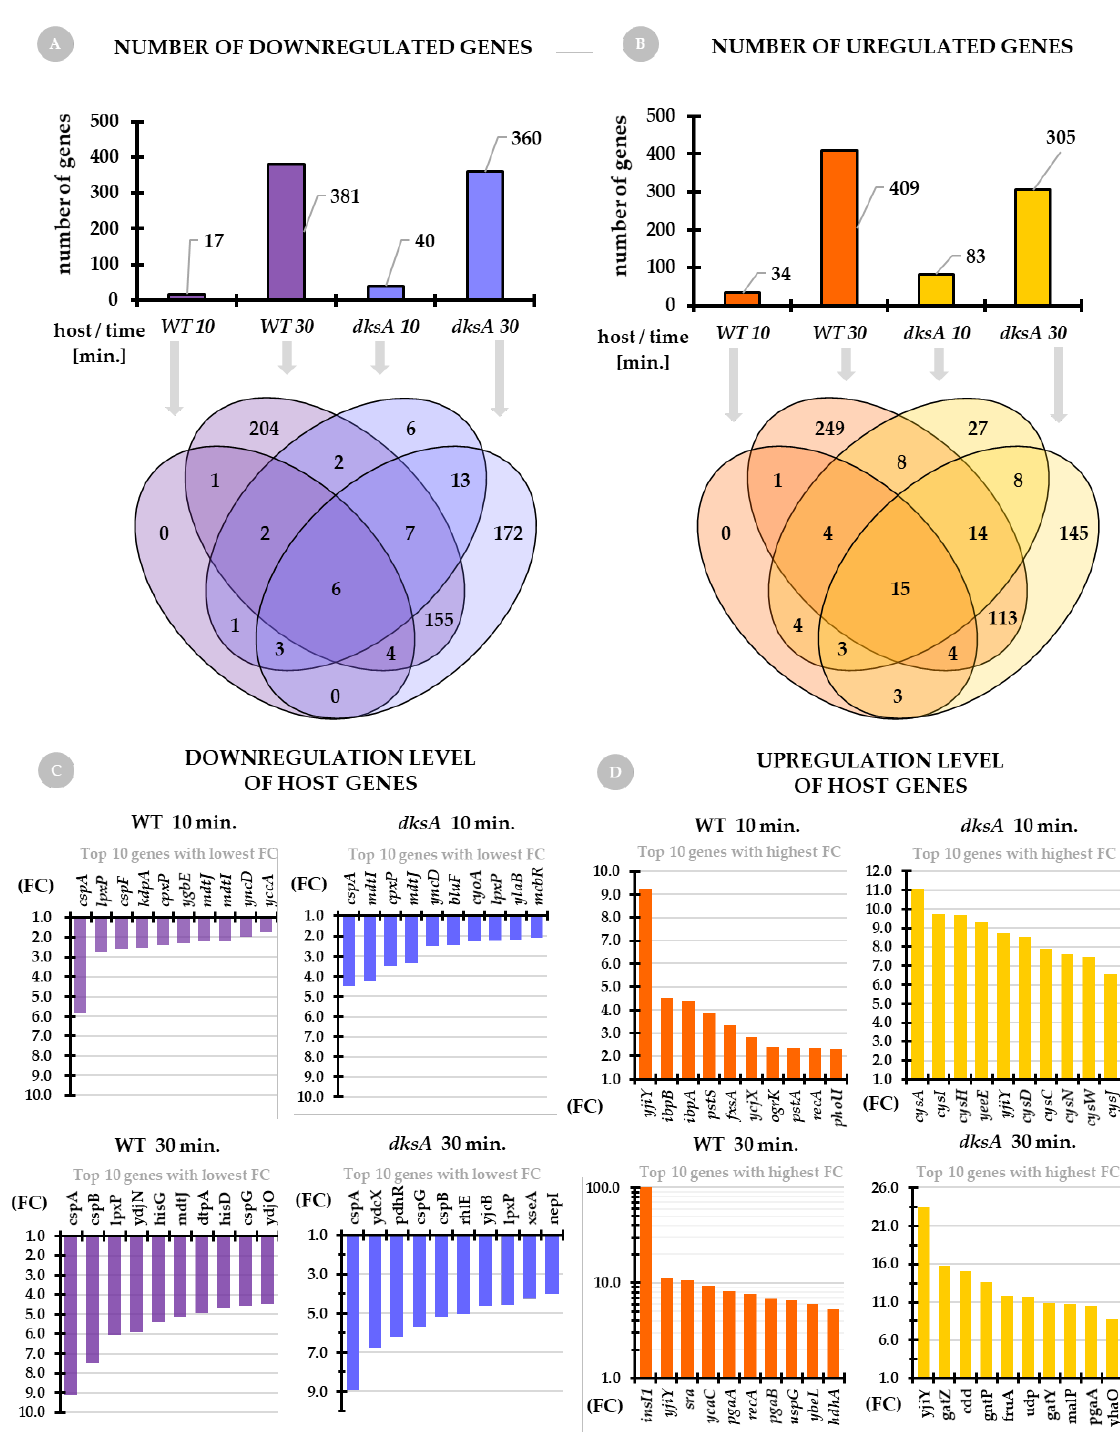
Figure 3. General overview of the host transcriptome upon P1 vir infection. Panel ( A ) shows the number of downregulated genes of both, the wild type and dksA mutant hosts at 10 min and 30 min post-P1 vir infection. Panel ( B ) shows the number of upregulated genes of both hosts at selected time points upon P1 vir infection. Venn diagrams below panels A and B show the distribution of up- or downregulated genes. Panel ( C ) shows the downregulation level of the top ten genes with the lowest expression at each time-point and host. Panel ( D ) shows the upregulation level of the top ten genes with the highest expression at each time-point and host. Genes with Fold Change (FC) > 1.5 were selected for further analysis. Gene descriptions are in the text and Appendix A, Table A1.